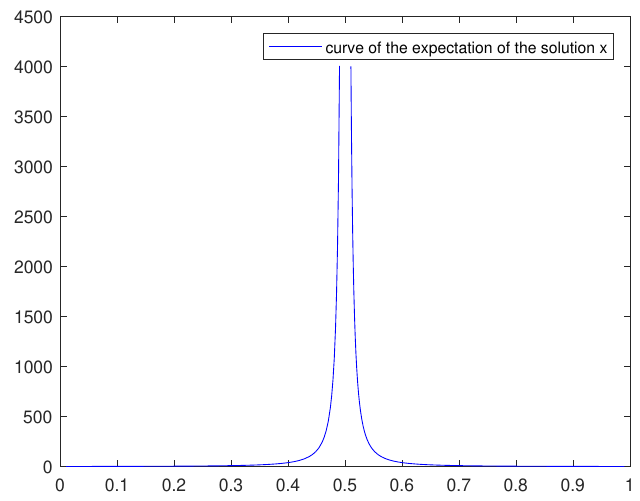
Figure 1. Expectation of the extremal to the stochastic fractional problem of the calculus of variations of Example